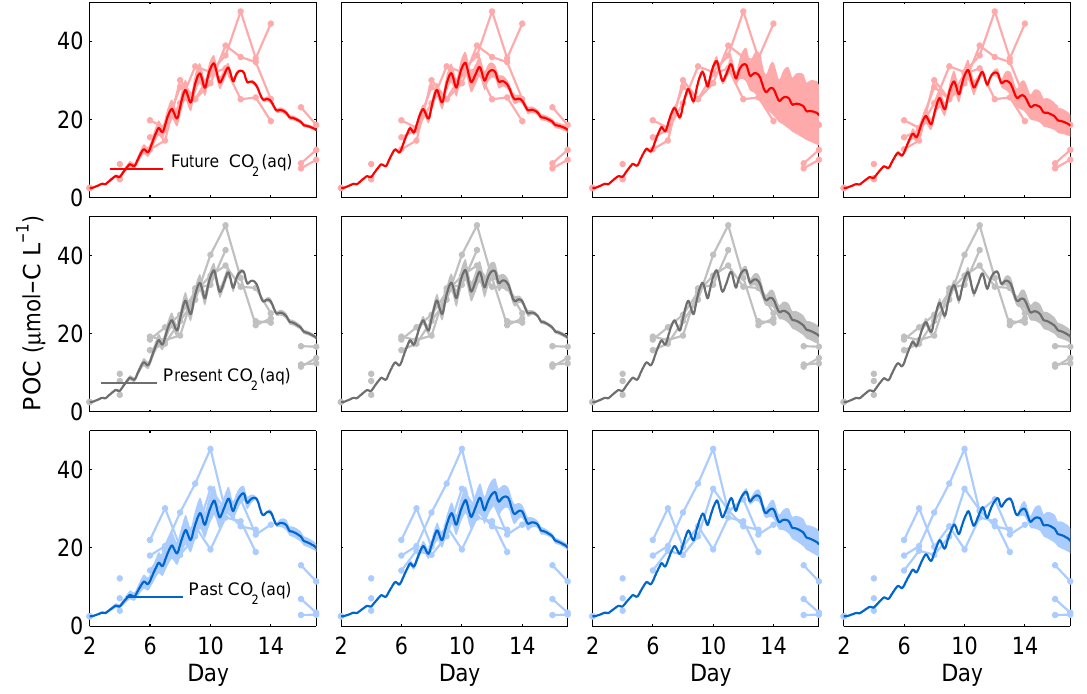
Figure 6. As Fig. 5, for PeECE III.